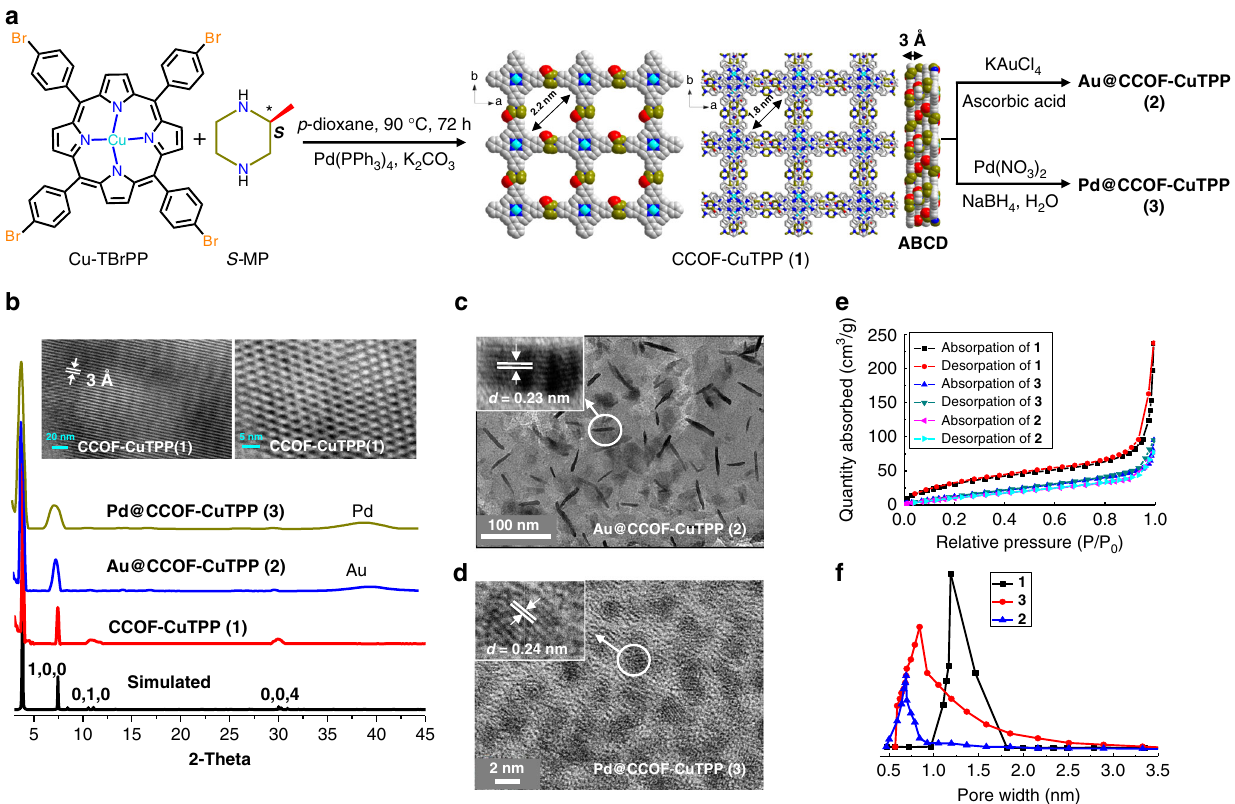
Fig. 1 Synthesis and characterization of 1 – 3 . a Synthesis of 1 – 3 . Single 2D layer and crystal packing patterns of 1 . b Simulated and measured PXRD patterns of CCOF-CuTPP ( 1 ), Au@CCOF-CuTPP ( 2 ) and Pd@CCOF-CuTPP ( 3 ). TEM images (side and top views) of 1 were inserted. c , d TEM images of 2 and 3 . Their SEM images are shown in Supplementary Fig. 1. e N 2 adsorption isotherms of 1 – 3 at 77 K. f The pore widths of 1 – 3 are centered at 1.20, 0.71, and 0.85 nm,